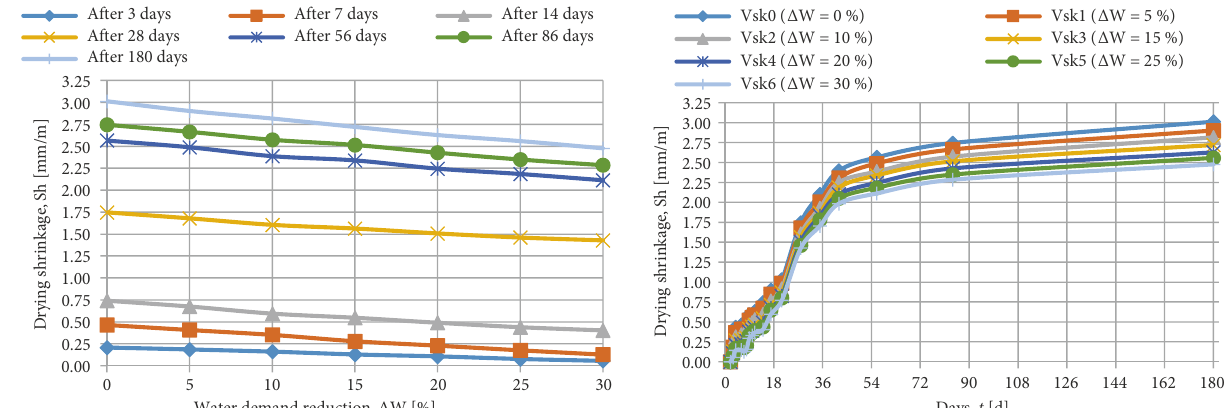
Figure 9. Dependence of the drying shrinkage of the cement mortars: a) on the reduction in the water demand; b) on the duration of curing Table 6. The technological properties of cement mortars with different water demand Mortar